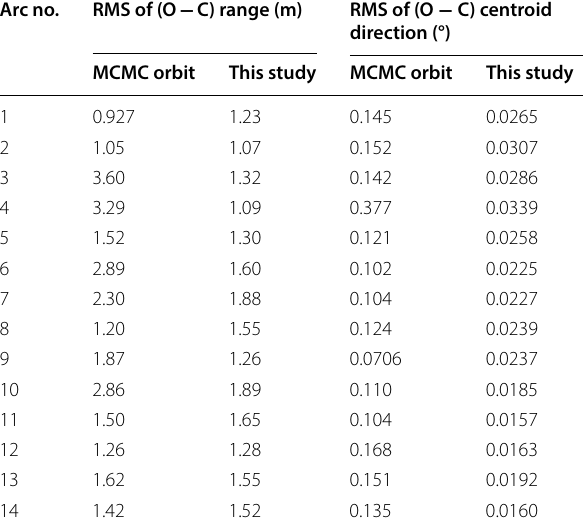
Computed ranges and centroid directions were derived from the MCMC orbit presented by Matsumoto et al. (2020) and the orbit of this study